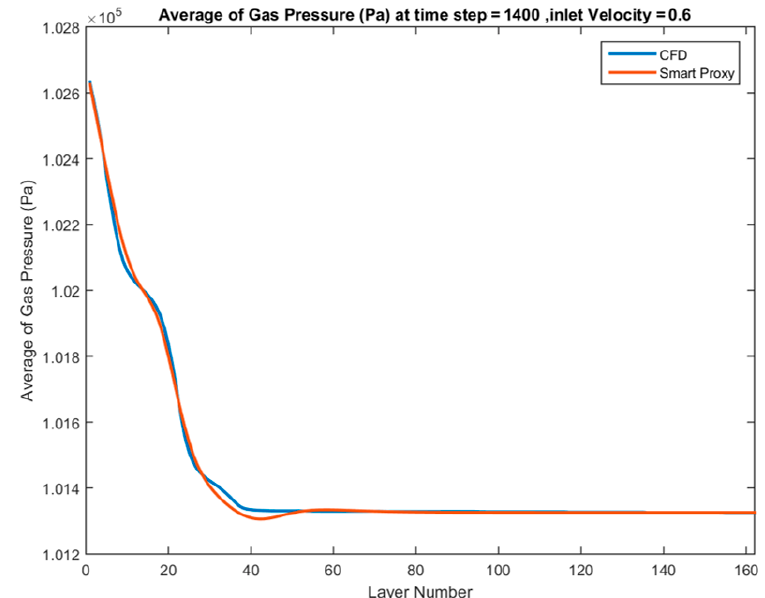
Figure 31. Spatially averaged CFD and smart proxy results for gas pressure (Pa) at time step = 1400 and V in = 0.6 m/s (with four static parameters). Fluids 2019 , 4 , x